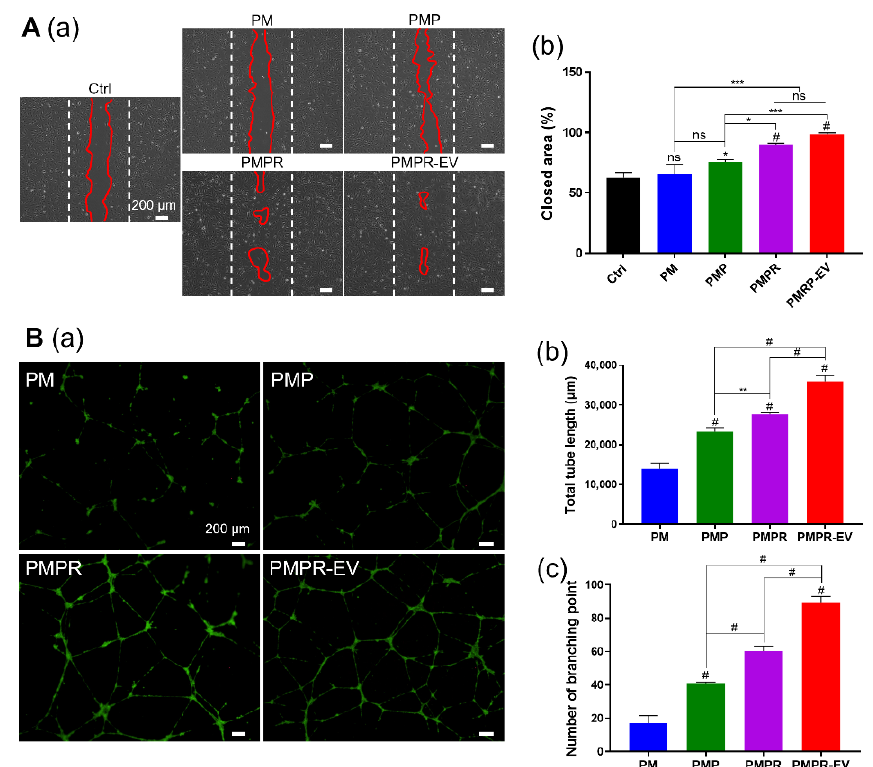
Figure 6. Re-endothelialization effects of the composites. ( A ) Optical images ( a ) and the ratio of the closed area ( b ) of wound-healing assay at 12 h. ( B ) Fluorescence images stained with calcein AM ( a ), quantification of total tube length ( b ), and the number of branch points ( c ) of the tubule-forming assay. * p < 0.05, ** p < 0.01, *** p < 0.001, and # p < 0.0001 indicate statistically significant differences, respectively.